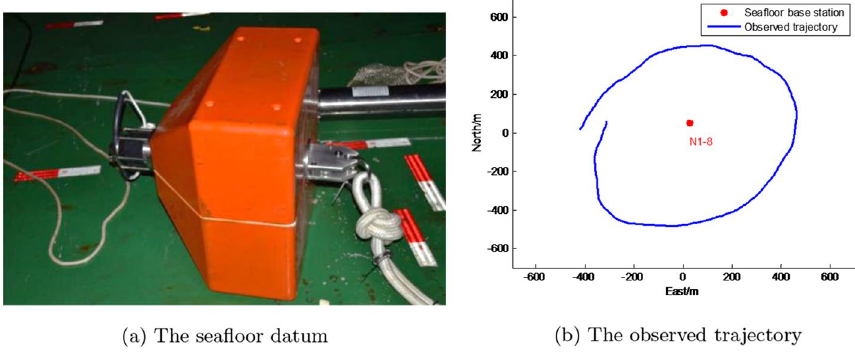
Fig. 8 Seafloor datum and the observed trajectory of position estimation